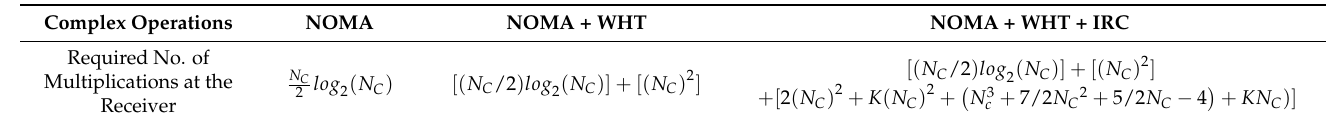
Table 4. Computational Complexity [10,34,37].